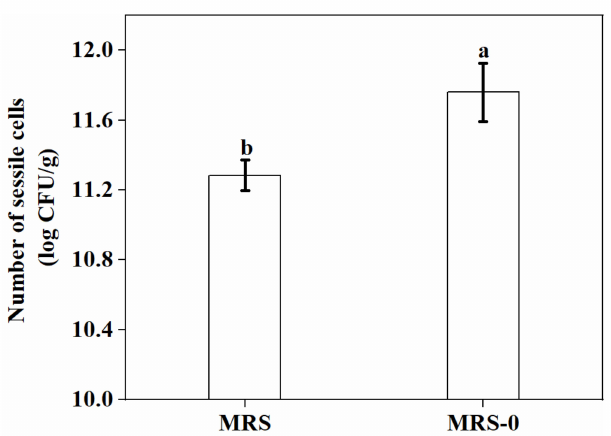
Figure 3. Effect of Tween 80 on the number of sessile cells in biofilms (MRS: with Tween 80; MRS-0: without Tween 80). Significant differences ( p < 0.05) are indicated by different letters (a and b).